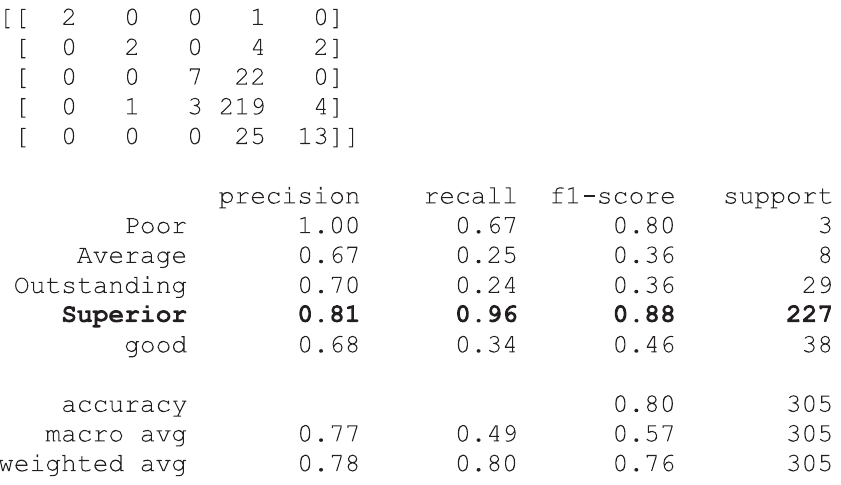
Figure 15: Gradient boosting confusion matrix and accuracy results.